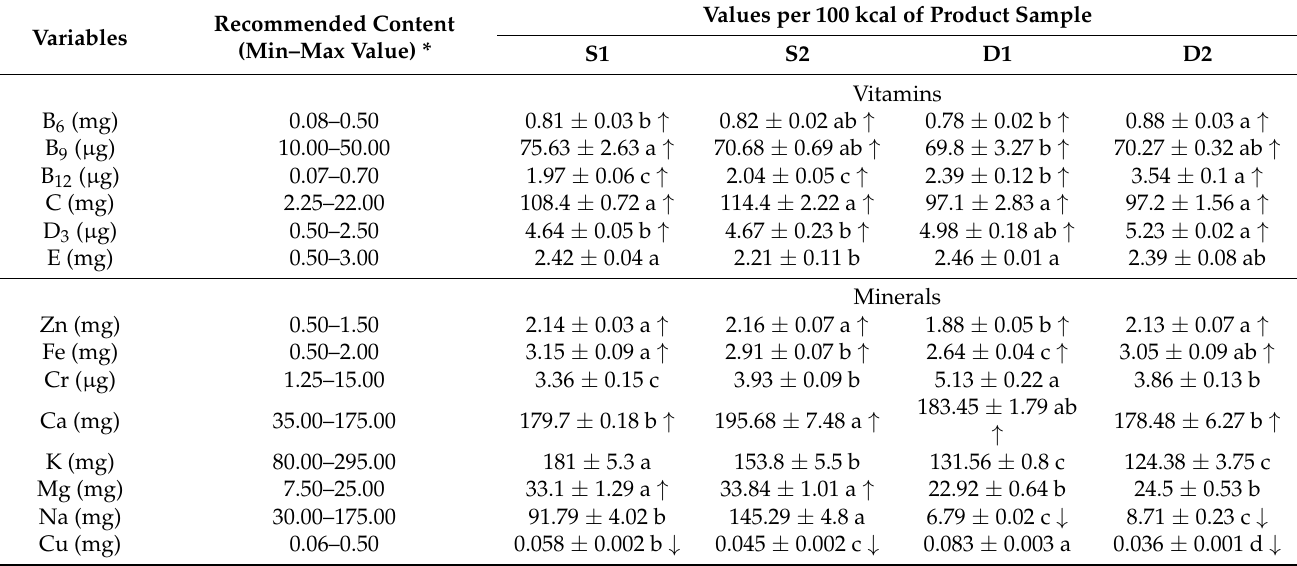
Table 7. Contents of the selected vitamins and minerals in industrially produced plant-based pur é es for OD